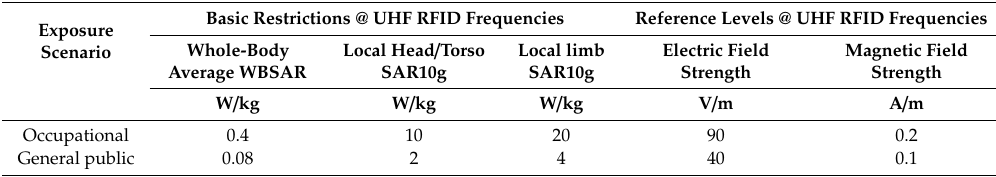
Table 1. International Commission on Non-ionizing Radiation Protection (ICNIRP)-based limitation of exposure to electromagnetic field (EMF) at frequencies used by ultra-high frequency radiofrequency identification (UHF RFID) systems (900